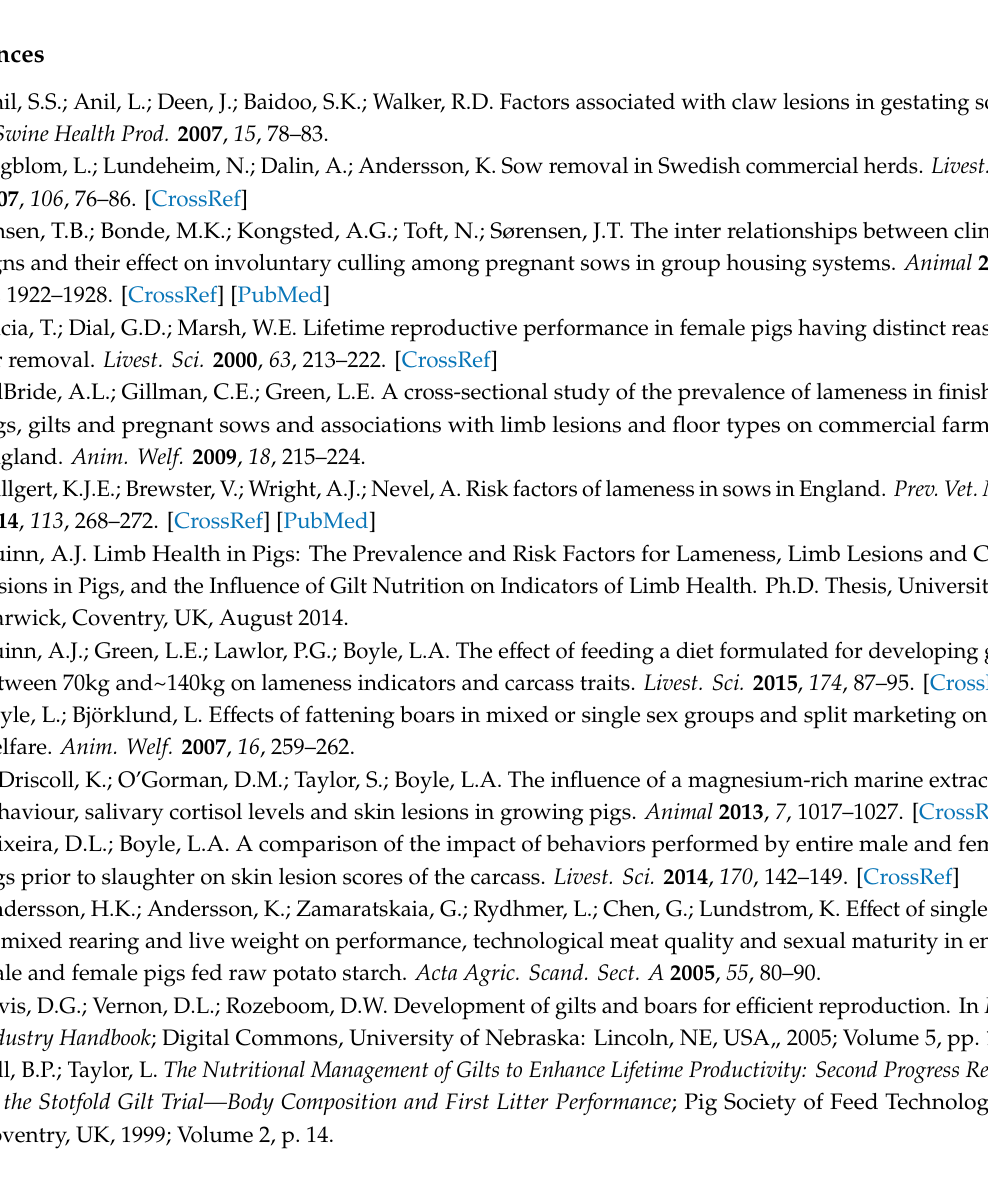
Table S1: Rules applied for statistical purposes using SAS 9.4 where numbers of scores at the extreme ends of scoring scales were too small to statistically